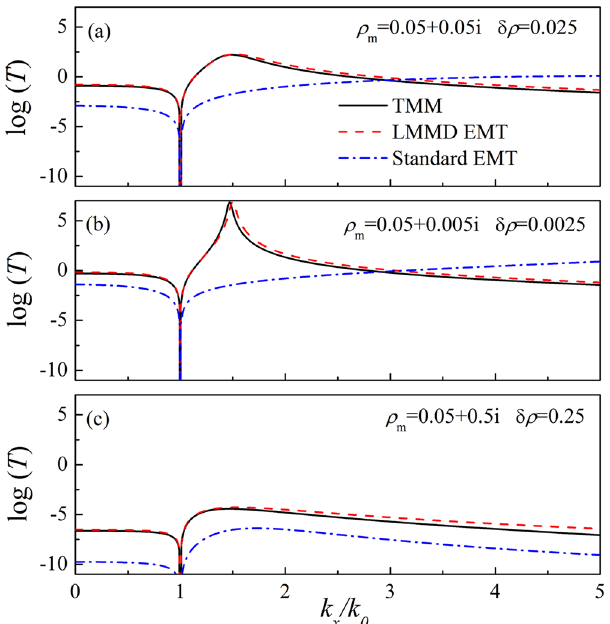
Figure 3. Logarithmic plot of the quantity